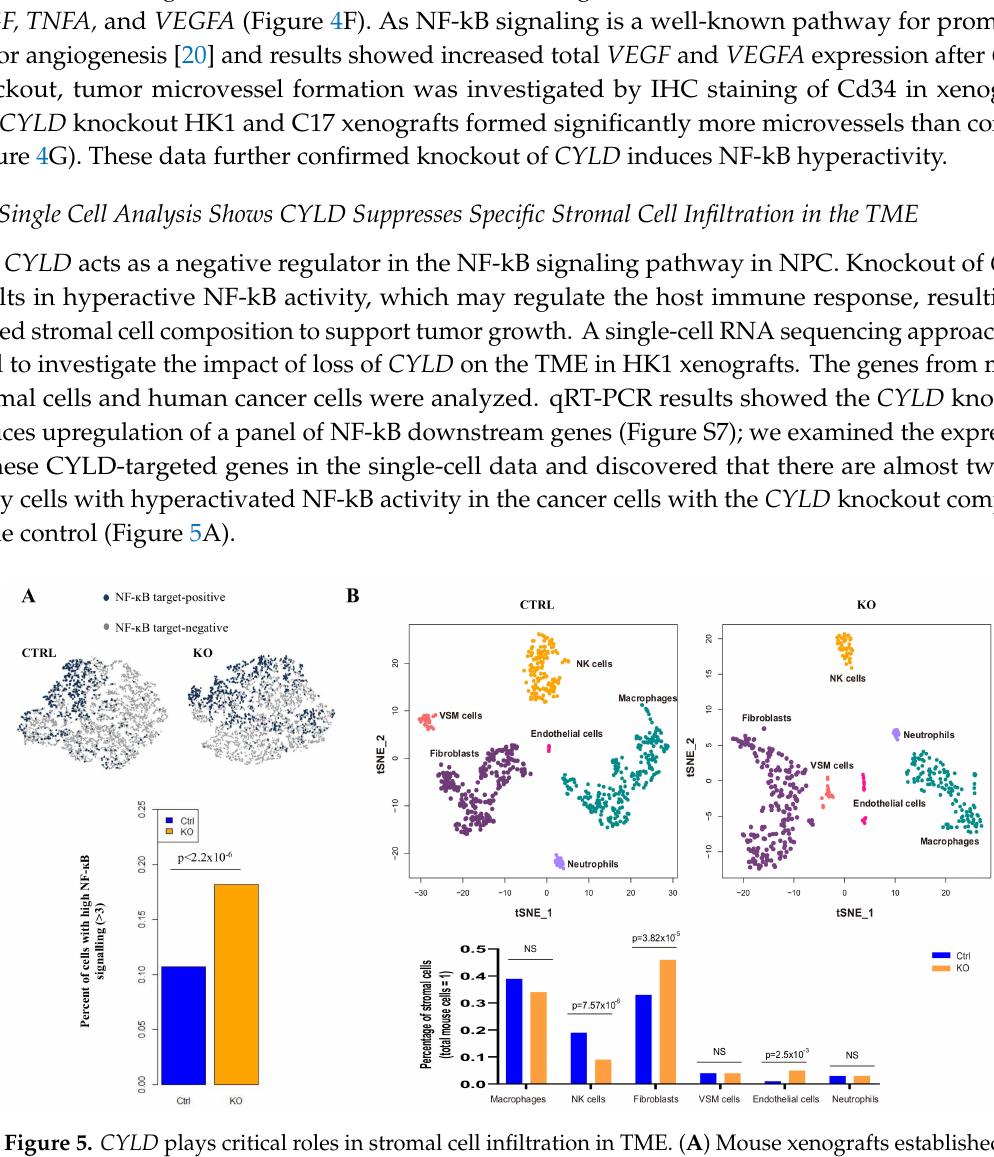
Figure 5. CYLD plays critical roles in stromal cell infiltration in TME. ( A ) Mouse xenografts established from HK1 cells transduced with control ( n = 2) and CYLD knockout ( n = 2) were used for single-cell RNA-Seq analysis. The panel of NF-kB downstream genes mediated by CYLD was set as an indicator of high NF-kB activity in human cancer cells. These genes include BCL2A1, CXCL10, MMP9, SERPINB2 , total VEGF, TNFA, VEGFA, SOD2, VCAM, CXCL1 , and EGFR . The clusters show single cells with NF-kB target-positive (blue color) / target-negative (grey color). The bar graph shows significantly more